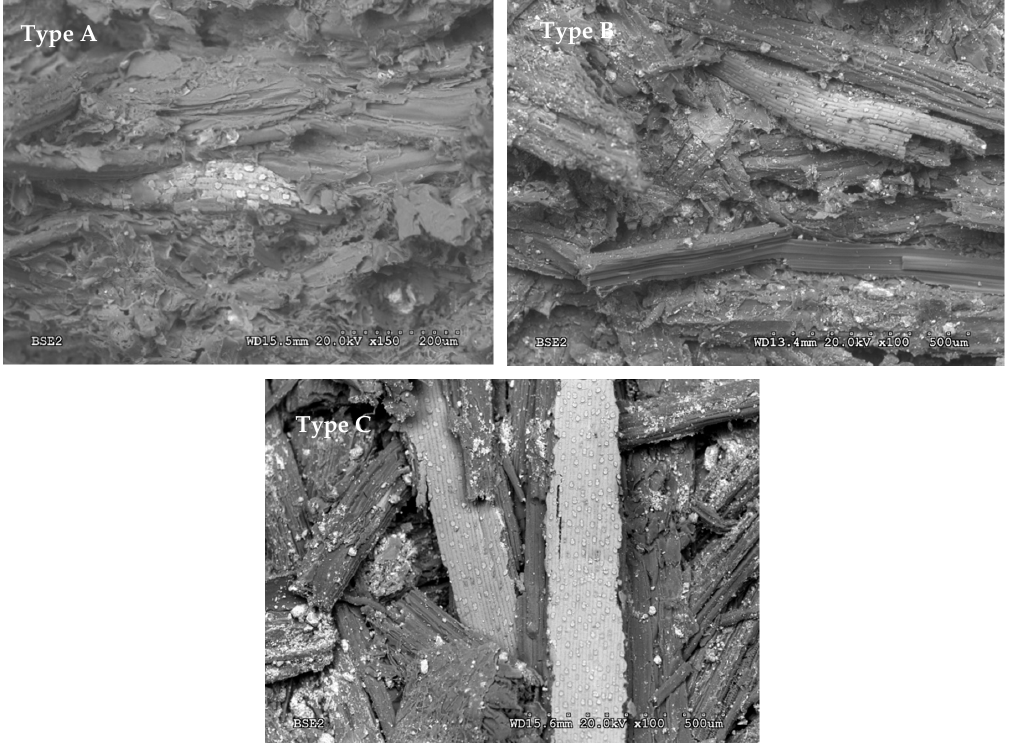
Figure 4. Micrographs of fracture surfaces of type A , B and C particleboards.